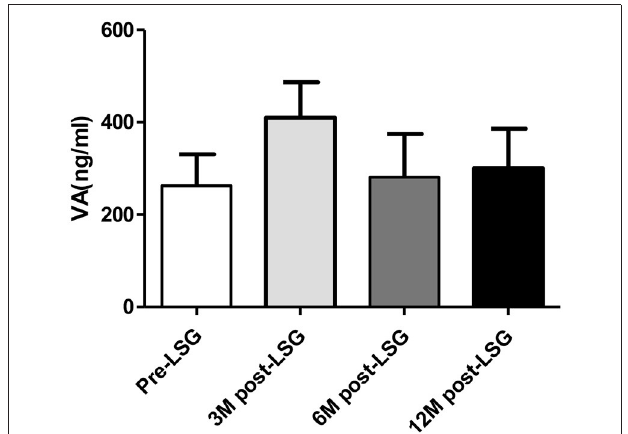
FIGURE 5 | Change in VA levels after LSG.